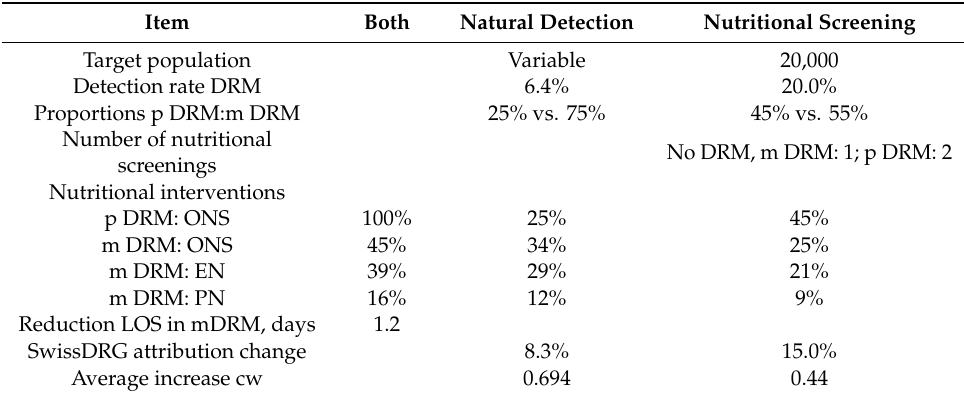
Table 1. Overview of the input data.